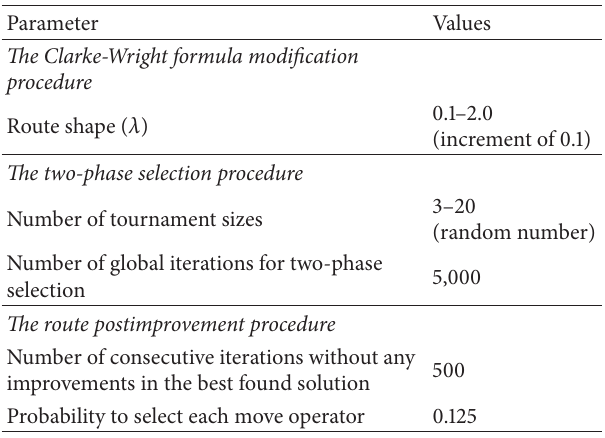
Table 1: The parameters used in the proposed CW.